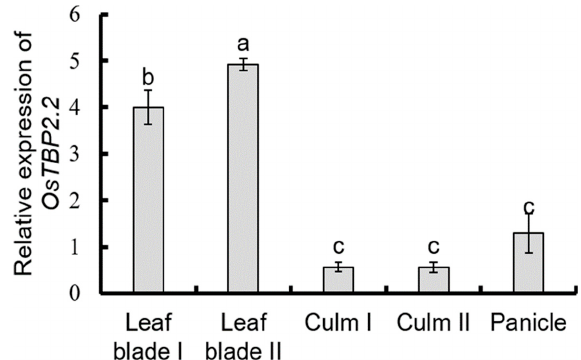
Figure 1. OsTBP2.2 expression pattern in different parts of rice. Rice RNA samples were collected during the flowering period and the expression of the gene OsTBP2.2 was detected in leaf blade I, leaf blade II, culm I, culm II and panicle. Error bars: SE ( n = 3). Significant differences are indicated by different letters.